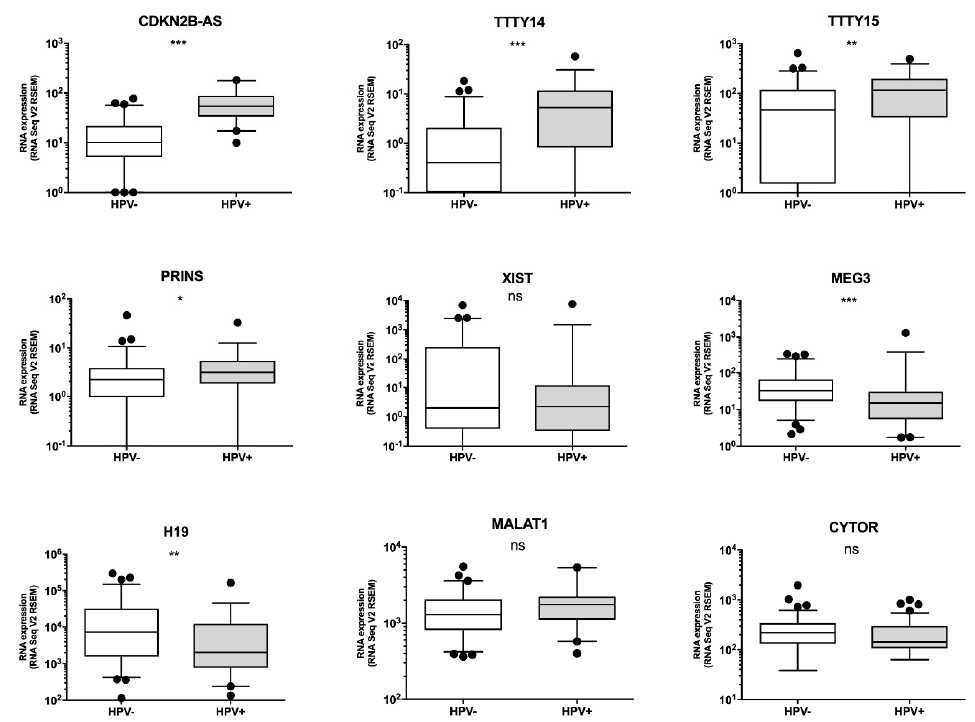
Figure 1. Expression levels of CDKN2B-AS1, TTTY14, TTTY15, PRINS, XIST, MEG3, H19, MALAT1, and CYTOR long non-coding RNAs (lncRNAs) in human papillomavirus (HPV)( − ) and HPV(+) head and neck squamous cell carcinoma (HNSCC) patients; un-paired T-test. The graphs show median values with standard error of the mean (SEM). ns: not significant, * p < 0.05, ** p < 0.01, *** p < 0.001.